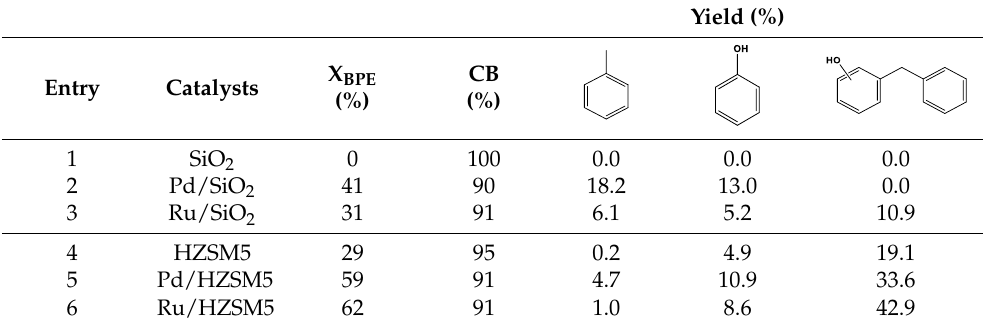
Table 3. Conversion of BPE, carbon balance, and product distribution for Ru- and Pd-based catalysts.